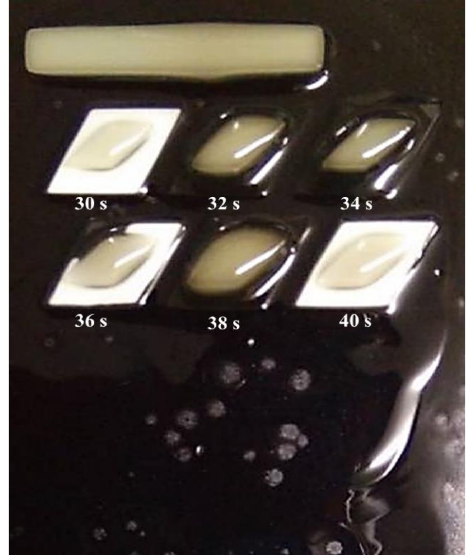
Figure 3. Curing times from 30 s to 40 s.